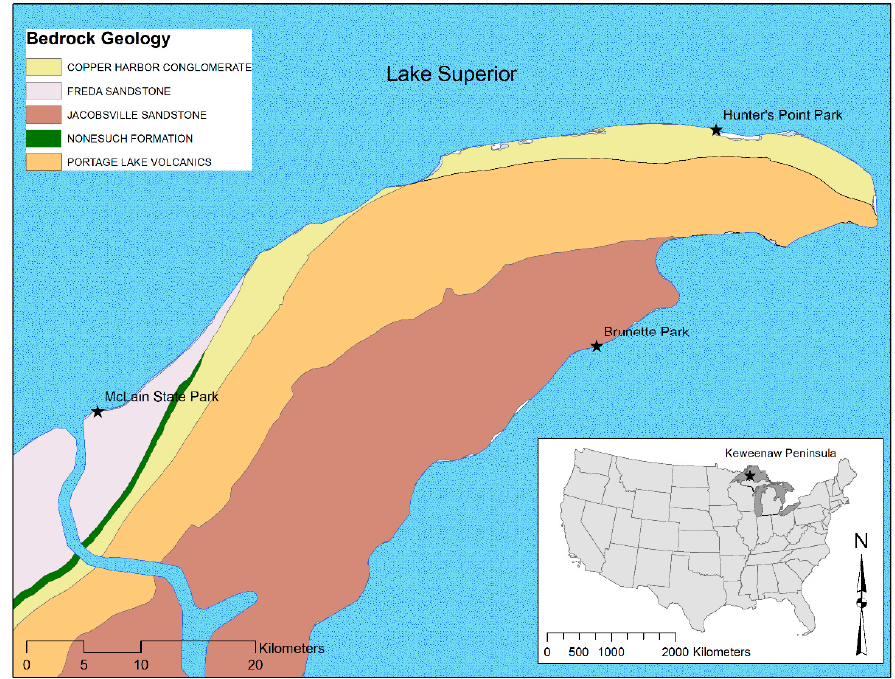
Figure 1. Geology of the Keweenaw Peninsula (Keweenaw Co., MI, USA) and project sample sites: McLain State Park, Hunter’s Point Park and Brunette Park.